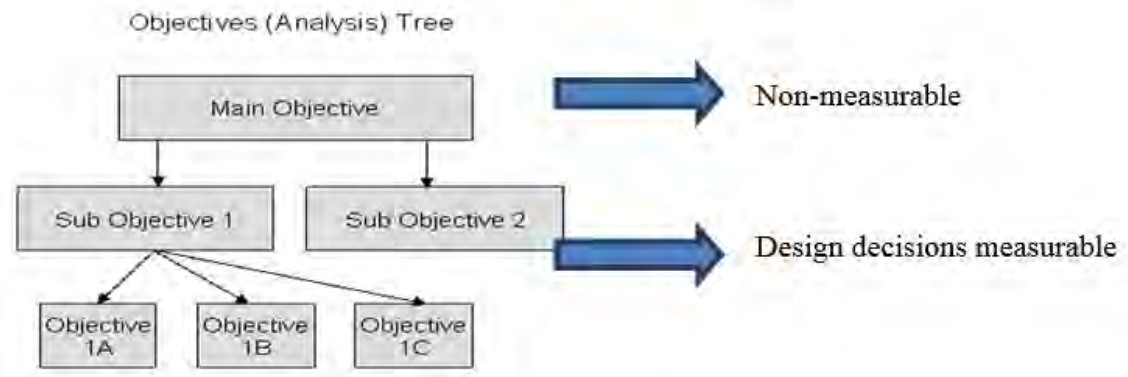
Figure 3. Tree of Objectives (Shehayeb,